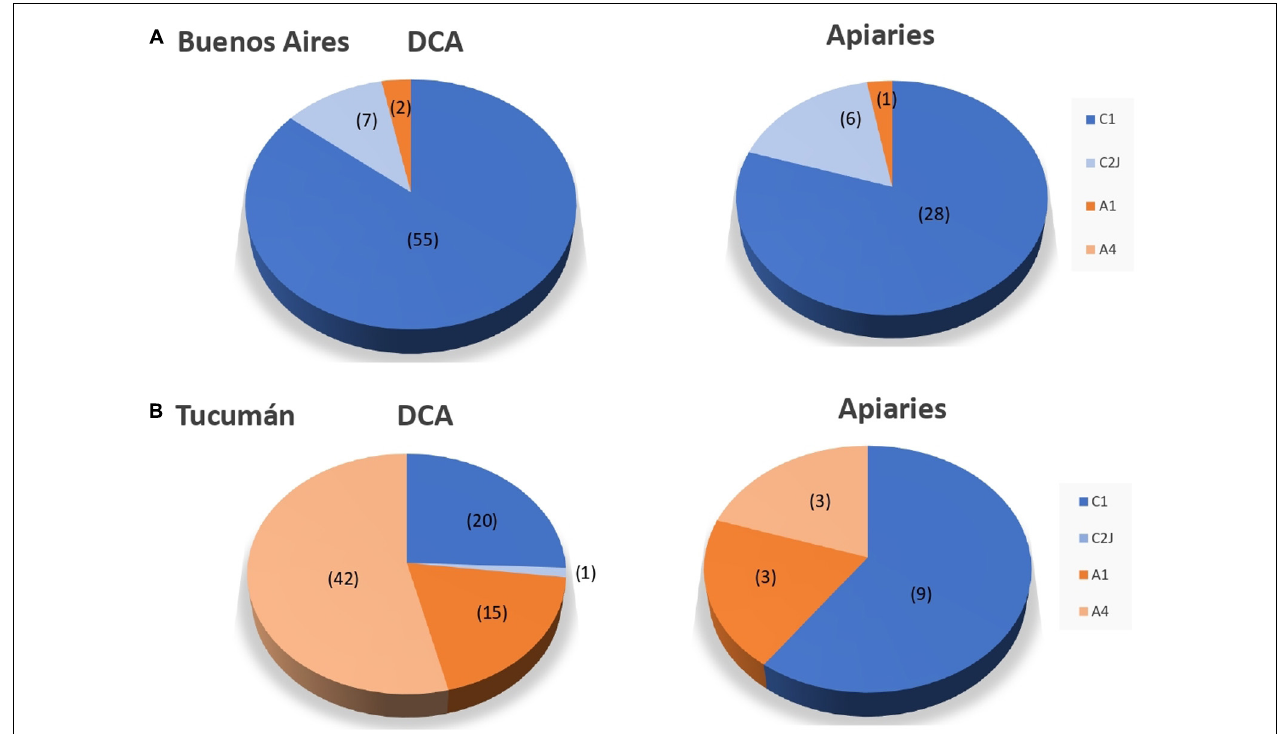
FIGURE 6 | Percentage of mitochondrial lineages of drones at the Drone Congregation Areas and workers at the nearest apiaries for (A) Buenos Aires and (B) Tucumán provinces. African-derived (A1, A4) and European-derived mitochondrial lineages (C1, C2j) are shown in orange and blue, respectively. Number of analyzed bees are shown between